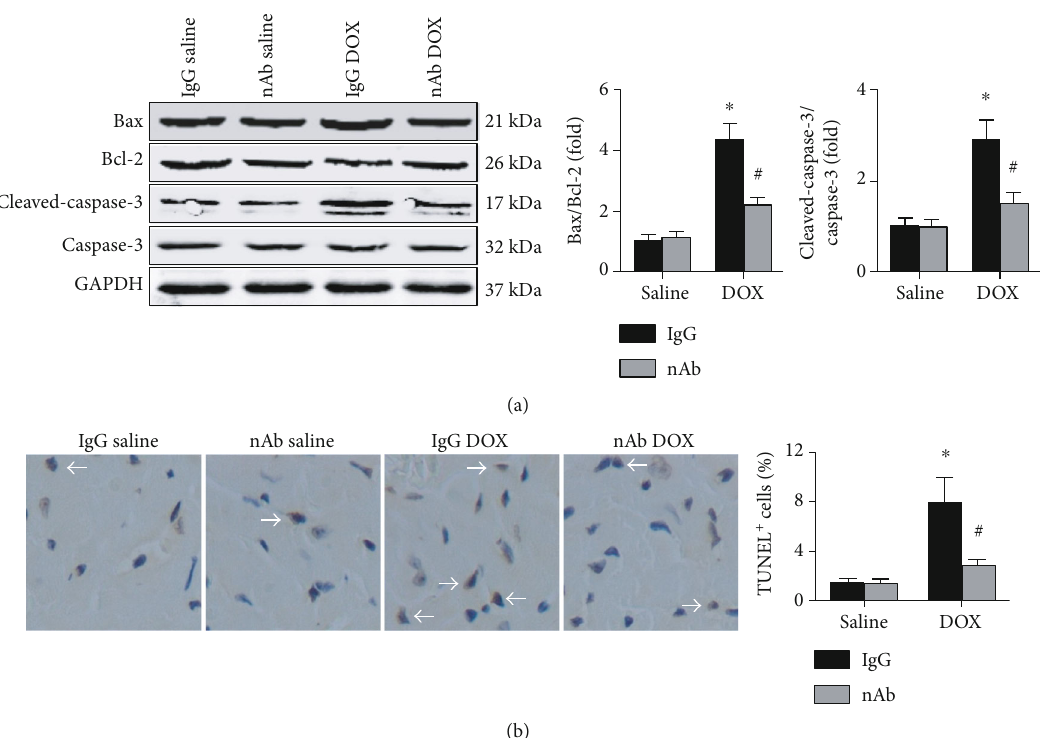
Figure 4: E ff ects of anti-IL-16 nAb on DOX-induced cardiomyocyte apoptosis. (a) Protein expression of Bax, Bcl-2, cleaved caspase-3, and caspase-3 were measured in the left ventricle, and the Bax/Bcl-2 and cleaved caspase-3/caspase-3 ratios were analyzed (ANOVA). (b) Cardiac TUNEL-positive cells were measured and analyzed. N = 5 for each group (200x, nonparametric test). ∗ p < 0 : 05 vs. the IgG saline group. # p < 0 : 05 vs. the IgG DOX